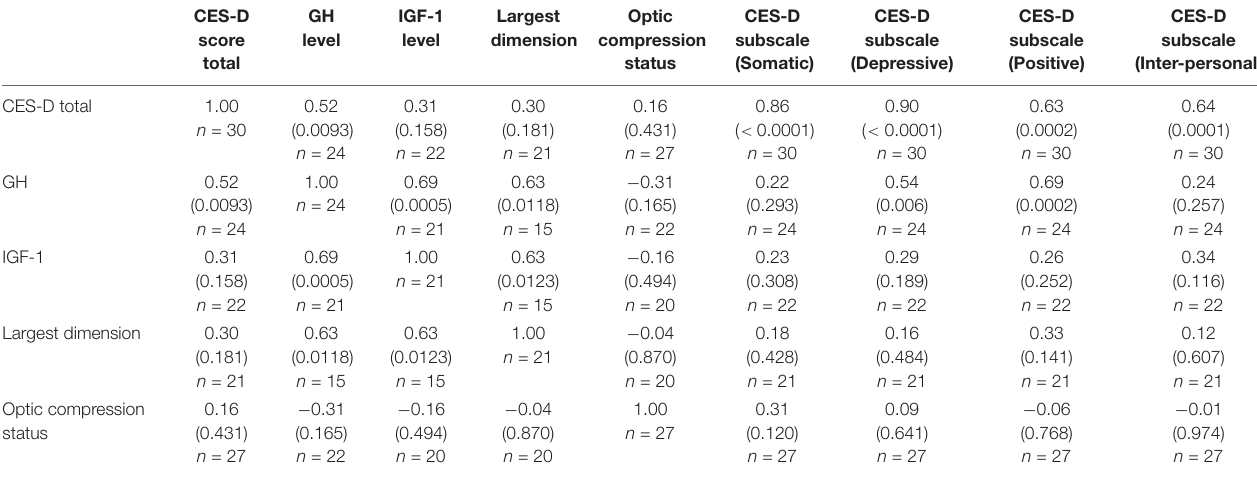
The values in this two-way table are presented as correlation coefficient (p-value). CES-D, Center for Epidemiologic Studies Depression Scale; GH, growth hormone; IGF-1, insulin-like growth factor-1.